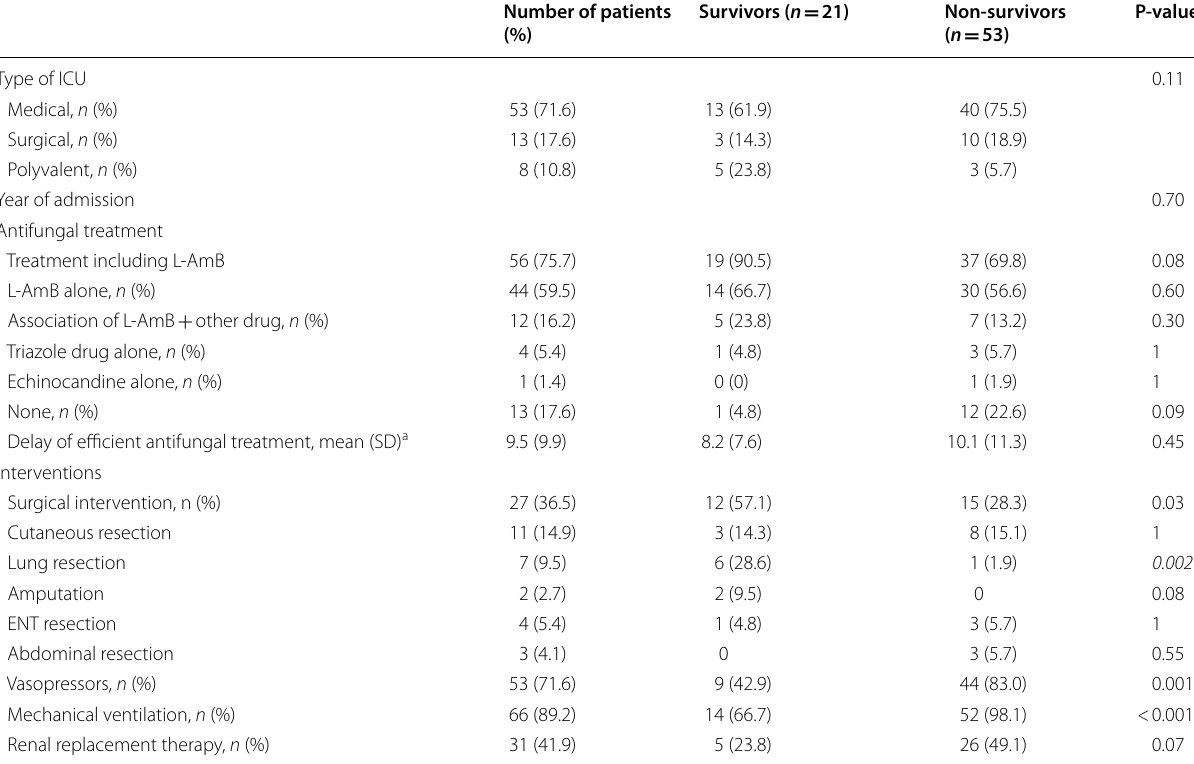
Table 2 Characteristics of ICU lengh stay and therapeutic